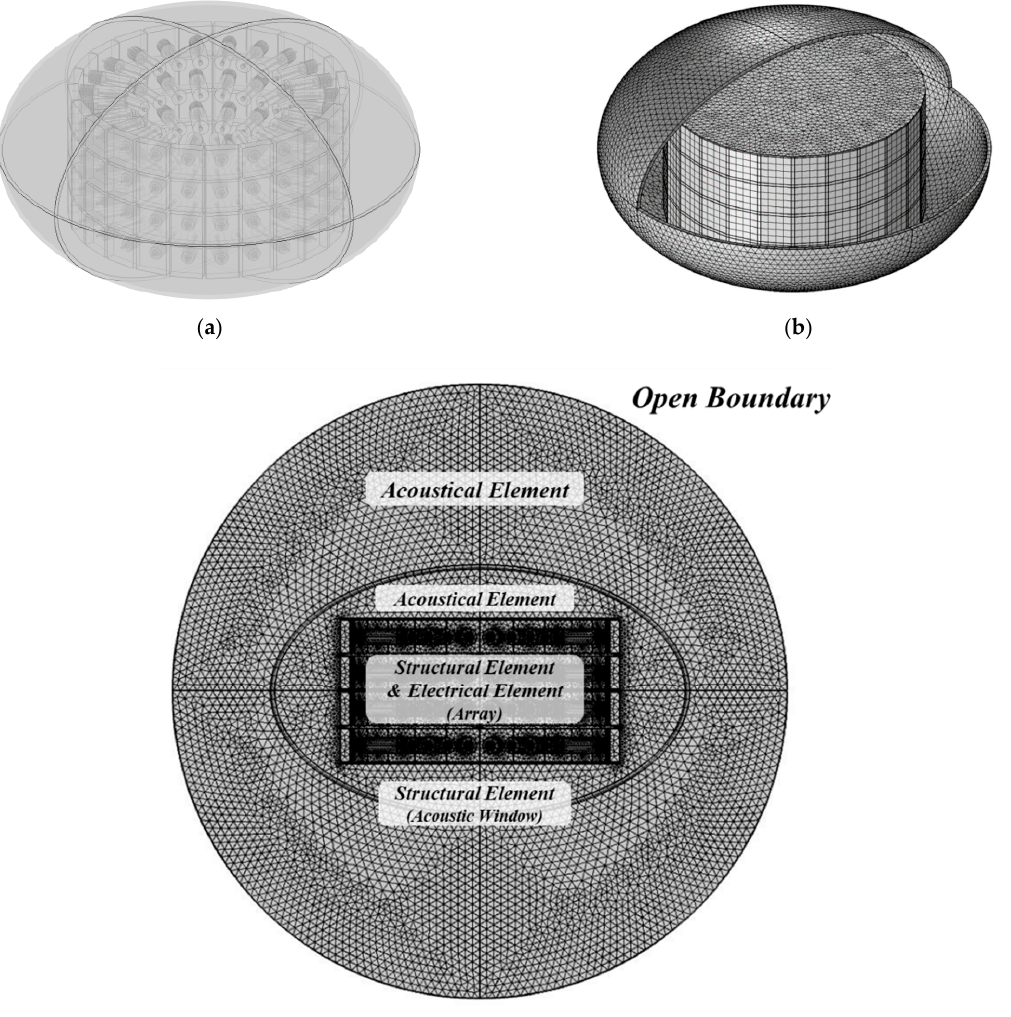
Figure 4. Cylindrical array surrounded by an oblate spheroid acoustic window: ( a ) Geometry. ( b ) FE-BE coupling model. ( c ) Conventional FE model.